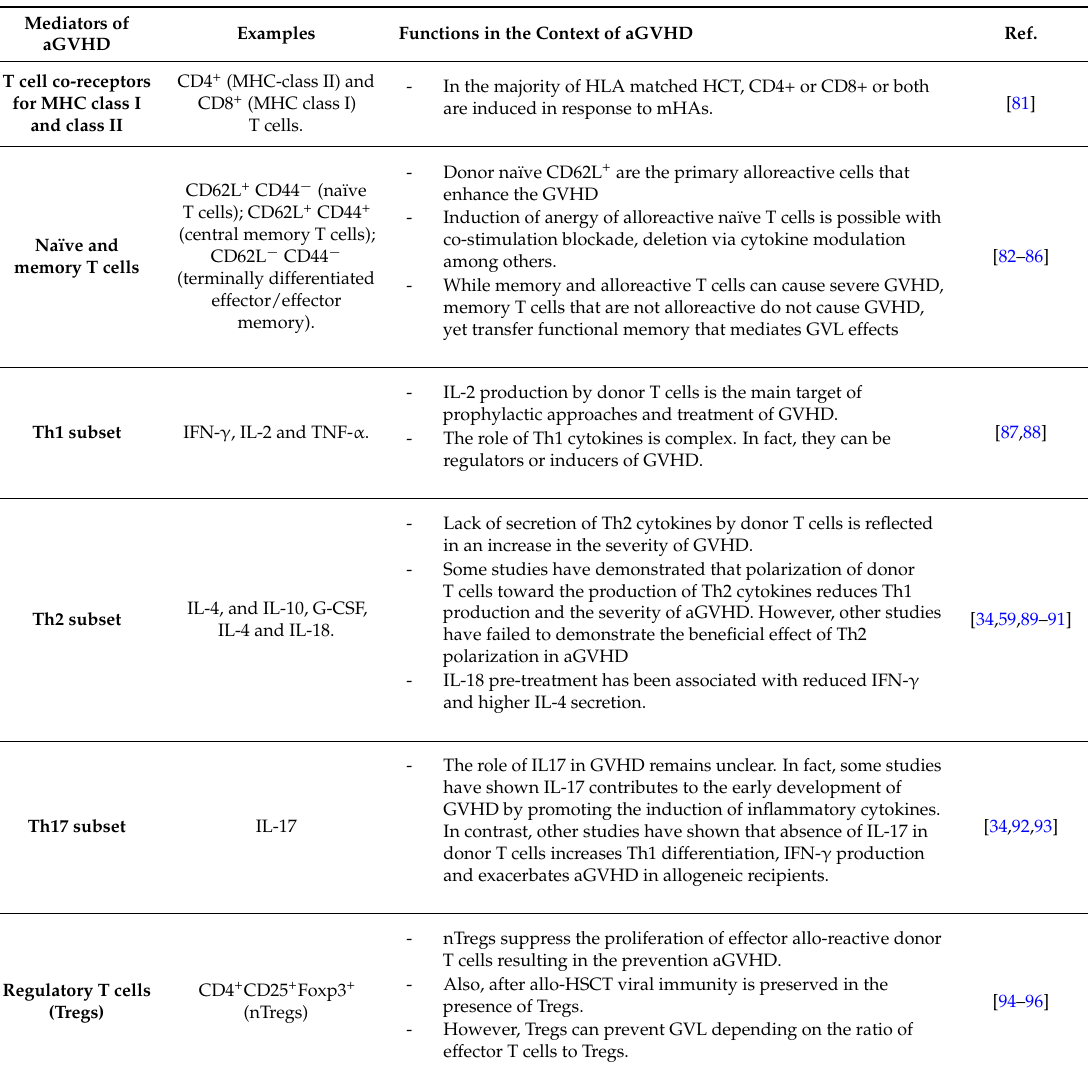
Table 1. Mediators of acute graft- versus -host